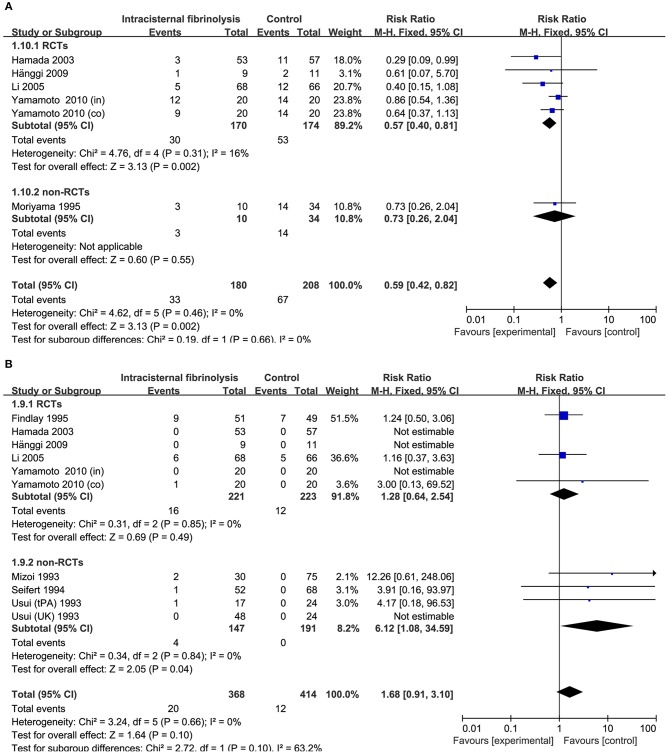
Meta-analysis of associations between intracisternal fibrinolysis and the risk of chronic hydrocephalus (A) or the risk of hemorrhagic complications (B) in patients with aSAH. aSAH, aneurysmal subarachnoid hemorrhage; CI, confidence interval; M–H, Mantel–Haenszel method; RCTs, randomized controlled trials.